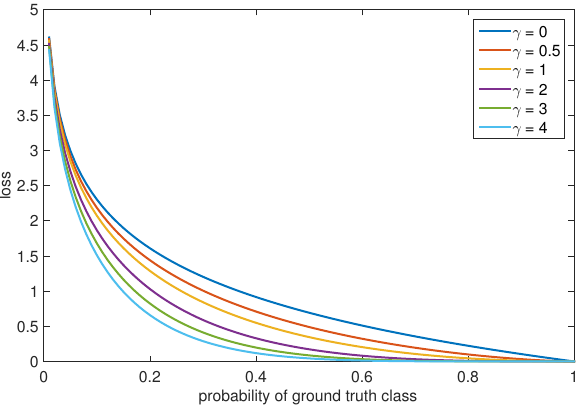
Figure 5. Focal loss curves for different values of γ .